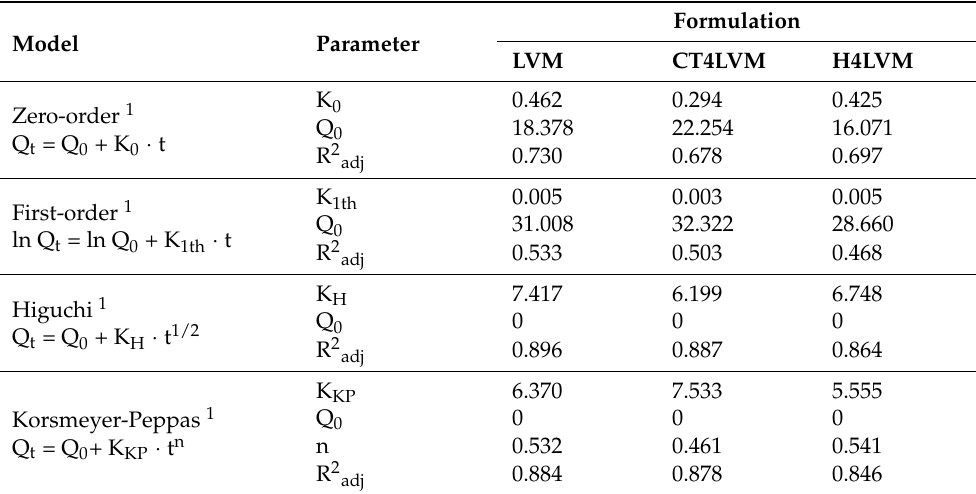
Table 3. Parameters of each model applied to the selected samples to study the mechanism of Curcumin